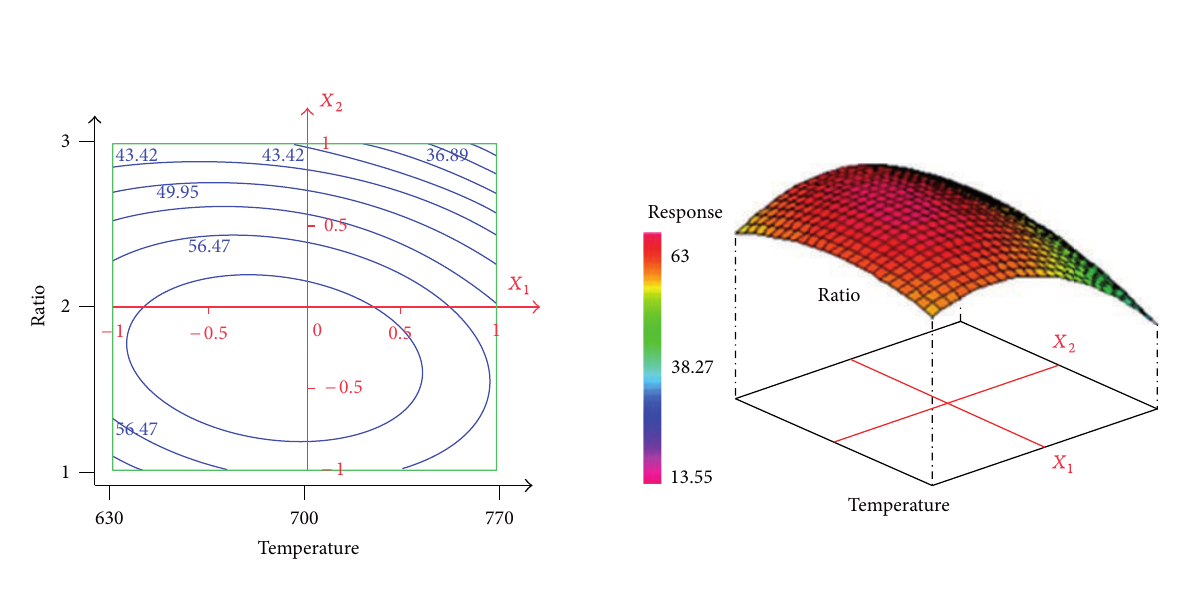
) in the plan temperature-ratio. 𝑌𝑌 1